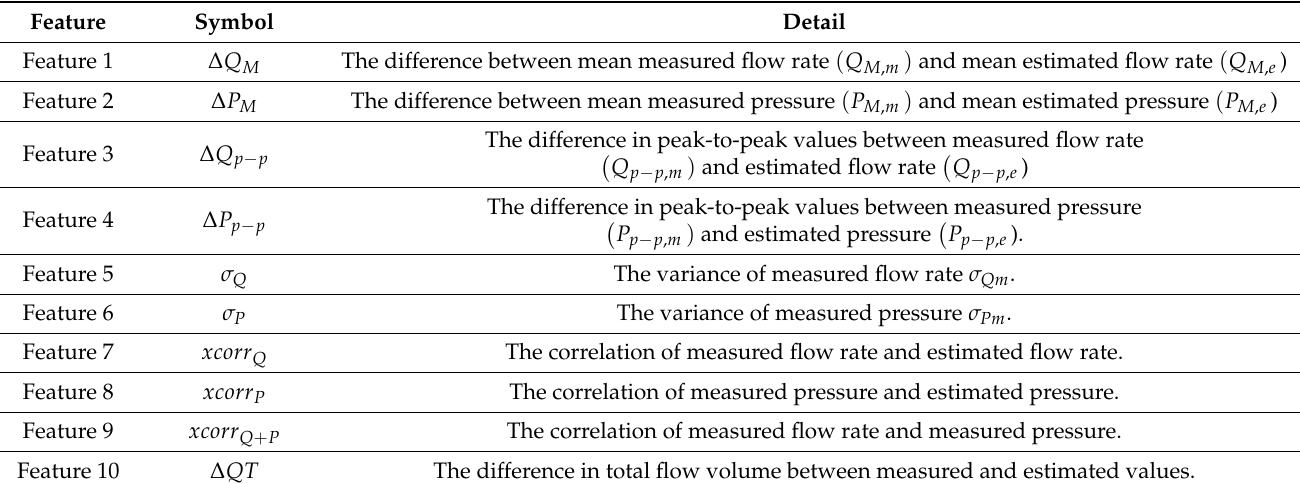
Table 1. Ten features for the proposed MC-MLI scheme.